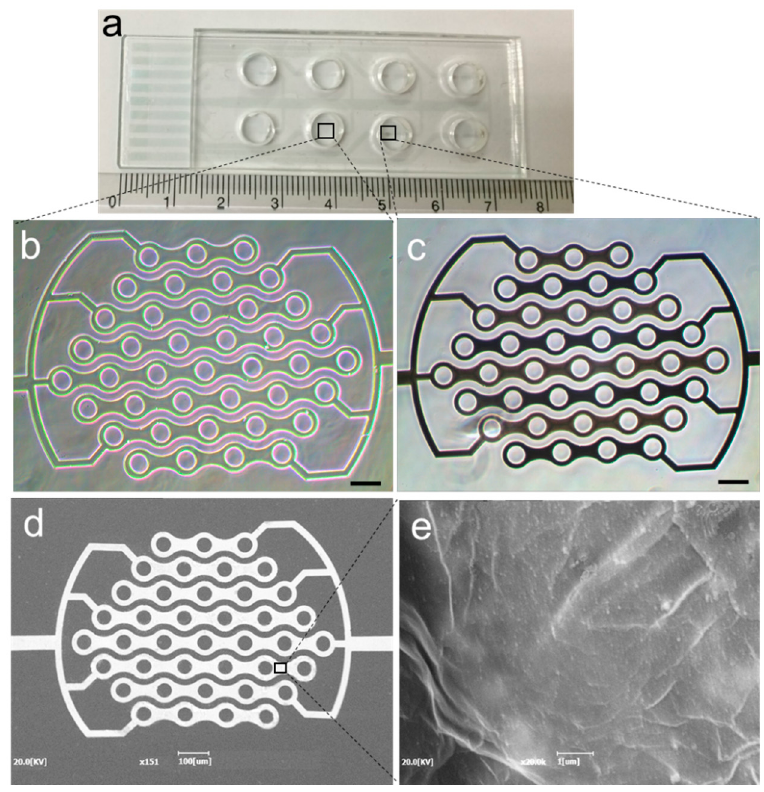
Figure 1. ( a ) Optical images of the fabricated interdigitated chain electrode (ICE) on a glass substrate attached with a polydimethylsiloxane chamber; ( b , c ) phase contrast micrographs of the bare and reduced graphene oxide (rGO) deposited on the sensing electrode of ICE respectively; scale bar is 100 µm; ( d ) SEM image of rGO deposited ICE and ( e ) shows the magnified view of the surface structure on one of its electrode arm.